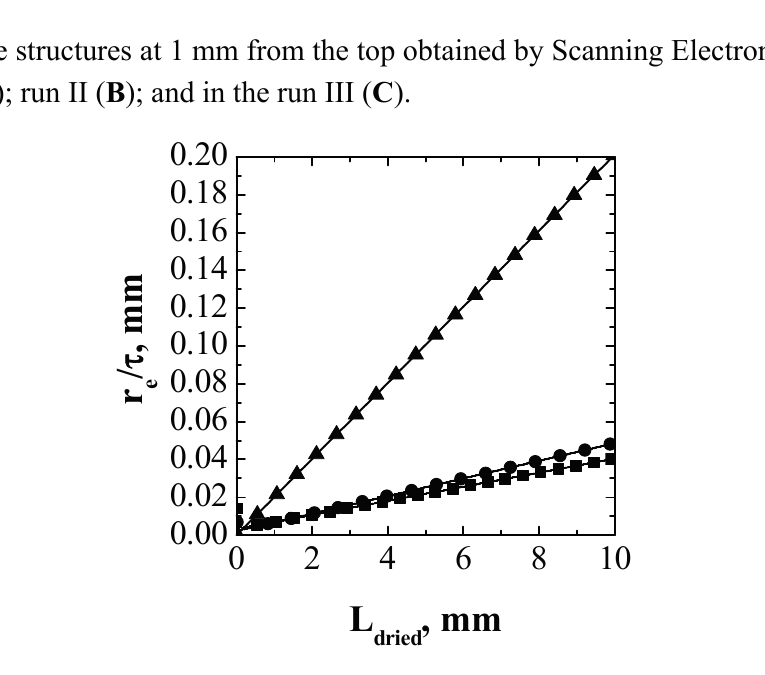
Figure 5. Values of r e / τ as a function of L dried calculated for type-I ( ■ ), type-II ( ● ), and type-III ( ▲ )